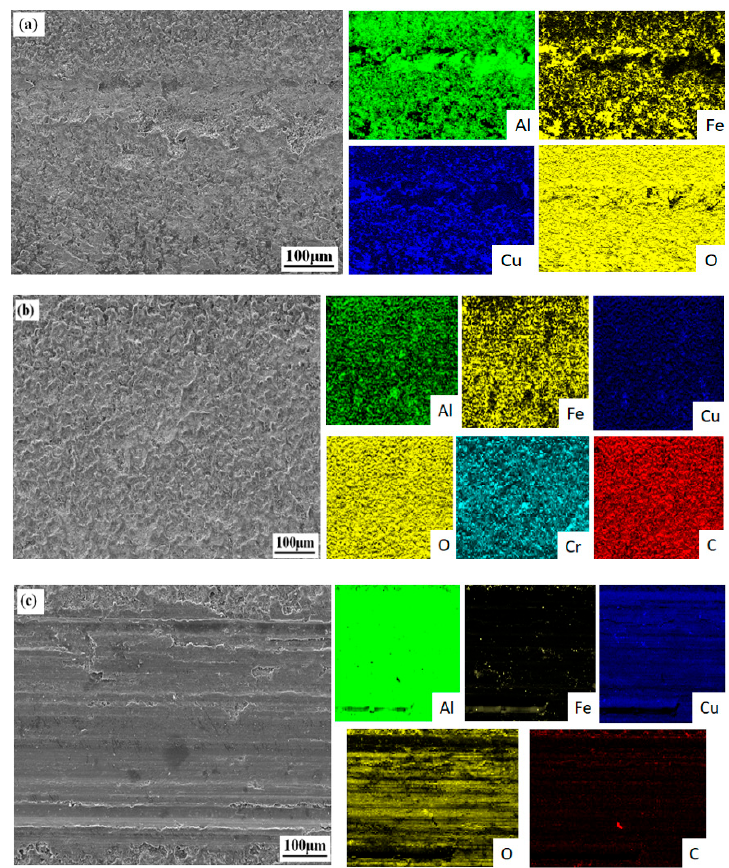
Figure 15. EDS mapping of the wear track of three PEO coatings with different concentrations of graphene: ( a ) G0, ( b ) G2, ( c ) G3. Table 4. Elemental compositions of the substrate and the coated samples after the wear test determined from EDS analysis.